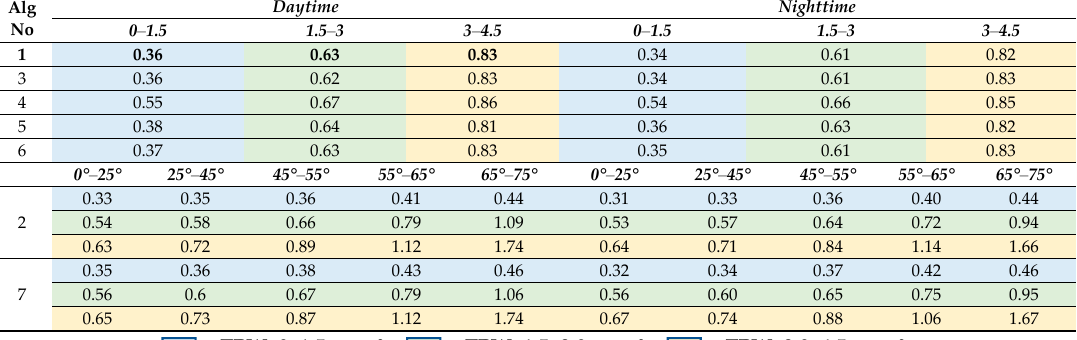
Table 4. The standard deviation errors (K) of the regression analysis.